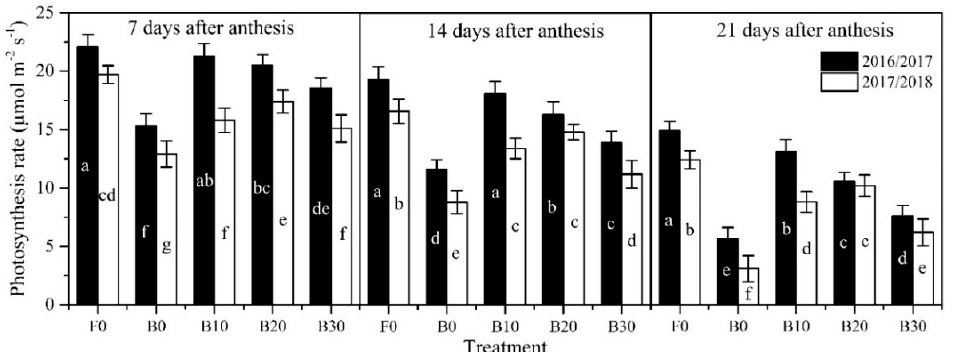
Figure 2. Interaction effect of year and treatment on photosynthesis rate at 7, 14, 21 days after anthesis. Values are average of four replications. Bars with different letters significantly different at 0.05. F0: freshwater irrigation. B0, B10, B20, B30: saline water irrigation combined with biochar application of 0, 10, 20, 30 t ha − 1 .